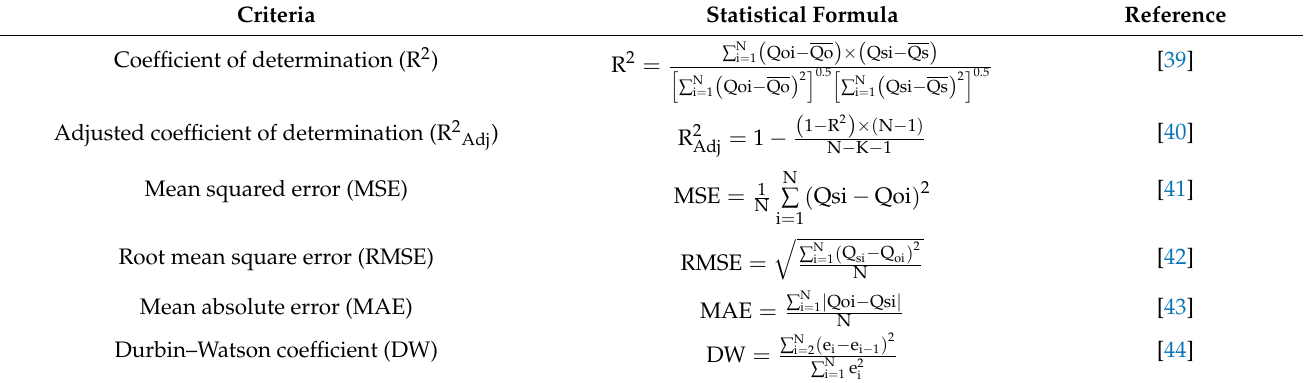
Table 1. Statistical criteria used to evaluate the performance of sub-models proposed in all climatic regions. Criteria Statistical